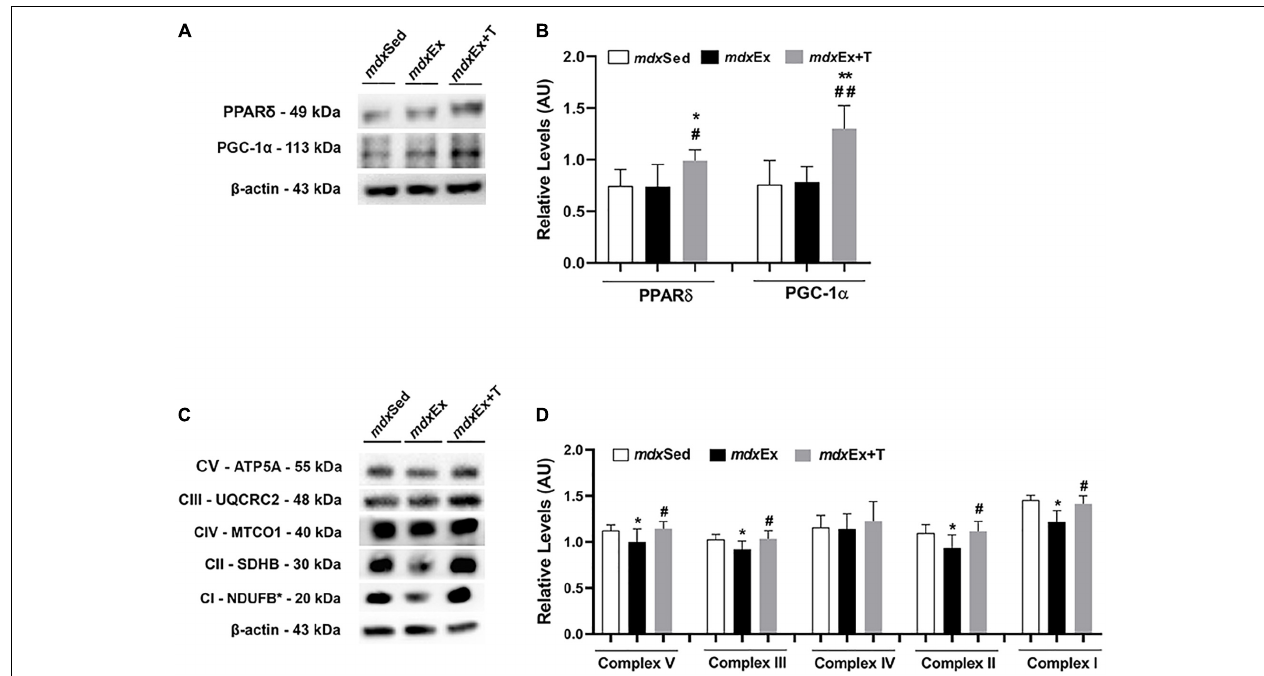
FIGURE 9 | Tempol effects on the activators of mitochondrial biogenesis and oxidative phosphorylation. (A) Western blotting analysis of peroxisome proliferator-activated receptor δ (PPAR δ ) and peroxisome proliferator-activated receptor- γ coactivator-1 α (PGC-1 α ) in the diaphragm (DIA) muscle from the sedentary mdx mice (mdx Sed), exercise trained mdx mice ( mdx Ex), and exercise trained mdx mice treated with Tempol ( mdx Ex+T). (B) The graphs show the PPAR δ and PGC-1 α levels in the crude extracts of DIA from the mdx Sed, mdx Ex, and mdx Ex+T groups. (C) Western blotting analysis of the OXPHOS complexes (complex V, III, IV, II, and I) in the DIA muscle from the mdx Sed, mdx Ex, and mdx Ex+T groups. (D) The graphs show the OXPHOS protein in the crude extracts of DIA from the mdx Sed, mdx Ex, and mdx Ex+T groups. The blots of the proteins (top row) and β -actin (loading control, bottom row) are shown. The intensities of each band were quantified and normalized to those of the corresponding control. All values expressed as mean ± standard deviation (SD). * P ≤ 0.05 compared with the mdx Sed group. ** P ≤ 0.001 compared with the mdx Sed group. # P ≤ 0.05 compared with the mdx Ex group. ## P ≤ 0.001 compared with the mdx Ex group (one-way ANOVA with Tukey’s post hoc